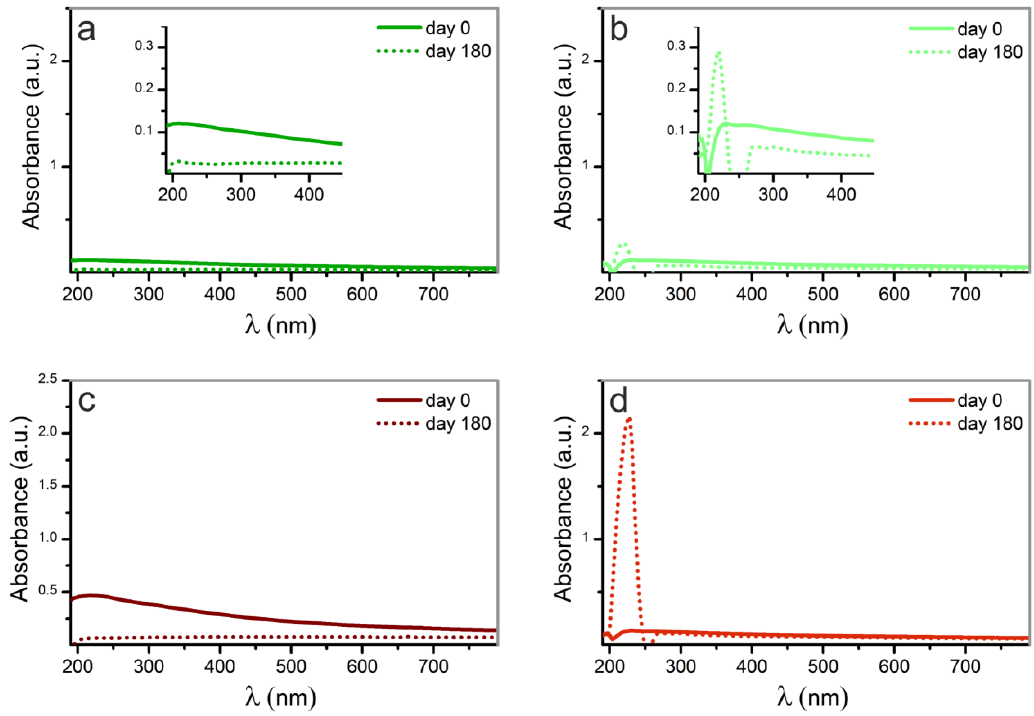
Figure 8. UV–VIS spectra of the Pd_NPs after 180 days, compared to the corresponding ones as ablated. Palladium nanoparticles synthesized by laser ablation with ( a ) 532 nm of wavelength in water, ( b ) 532 nm in methanol, ( c ) 1064 nm in water and ( d ) 1064 nm in methanol. Insets in figures ( a , b ) are enlargements of the zone of interest of the spectra.